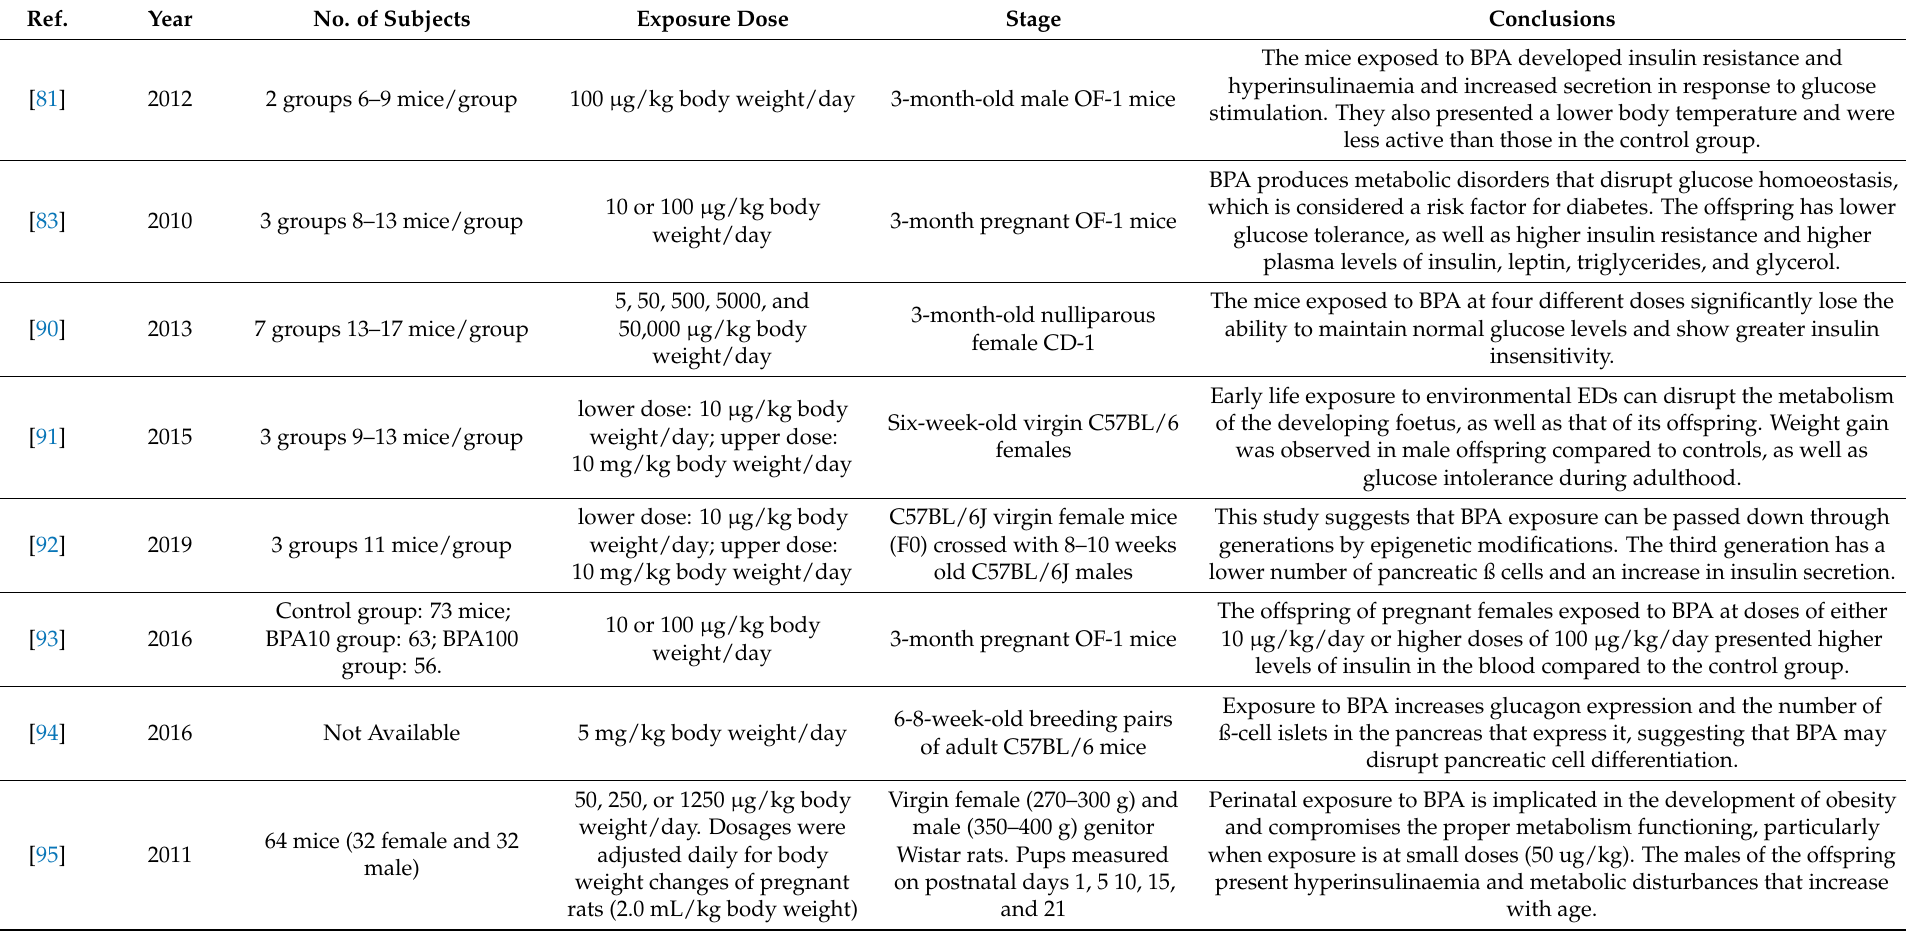
Table 1. Experimental studies in